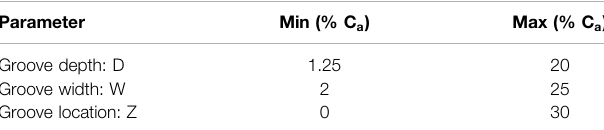
TABLE 2 | Ranges of groove